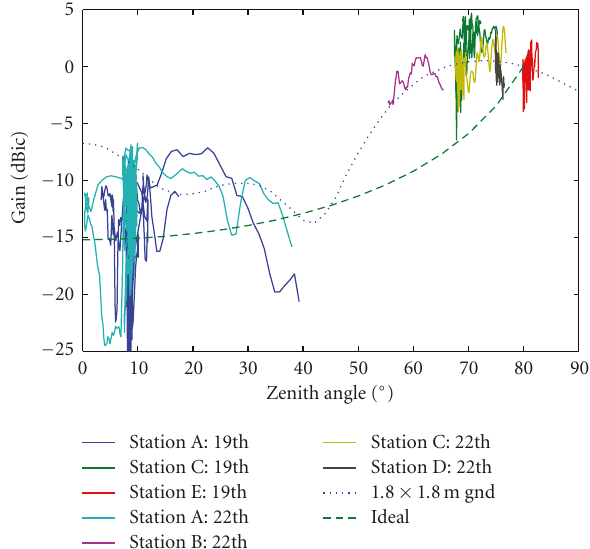
Figure 5: Reconstructed helical antenna gain paired with zenith angle; normalised to 83 ◦ gain level.